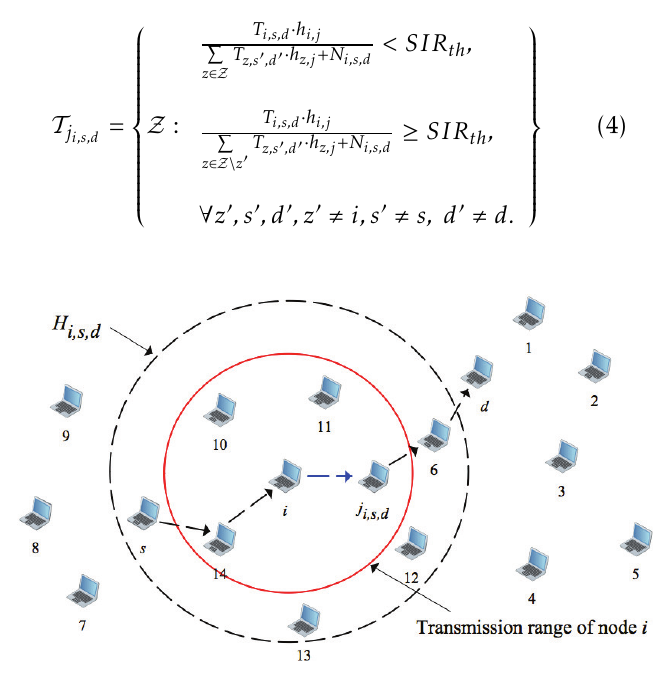
Figure 2. The plot shows the transmission range of node i and the set of real nodes H that can hear i when transmitting i,s,d to node j . The carrier sense CS of node i and the i,s,d i interference set T are not plotted because they depend j i,s,d on transmit powers of all nodes in the network as well as the topology and scale of the network. For instance H i,s,d = {{